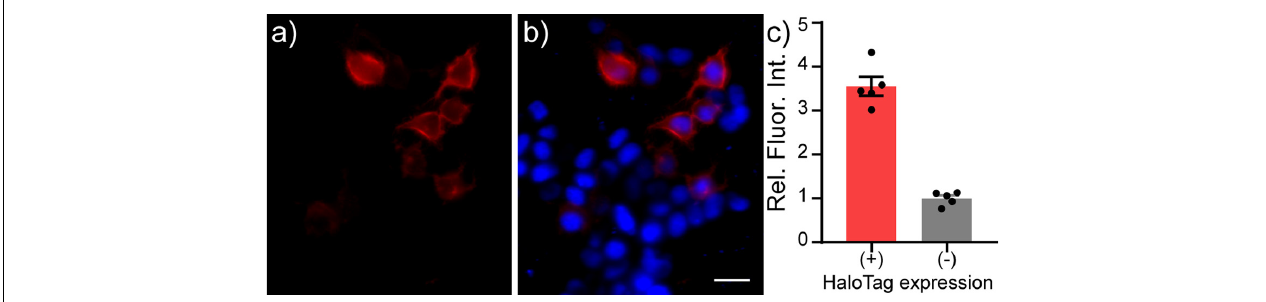
FIGURE 2 | Live-cell staining of RhoVR-Halo in HEK293T cells expressing HaloTag-CD4. Epifluorescence images of HEK293T cells expressing HaloTag-CD4 (CMV promoter) and stained with RhoVR-Halo (100 nM, red) and Hoechst 33342 (1 µ M, blue). Images show (a) RhoVR-Halo fluorescence and (b) an overlay of RhoVR-Halo and Hoechst fluorescence. Scale bar is 20 µ m. (c) Plot of relative fluorescence intensity in cells expressing HaloTag vs. cells that do not express HaloTag. HaloTag (+) cells were assigned based on a threshold obtained from a non-transfected control. Data are mean ± SEM for n = 5 different coverslips of cells. Data points represent average fluorescence intensities of 30–40 cells.